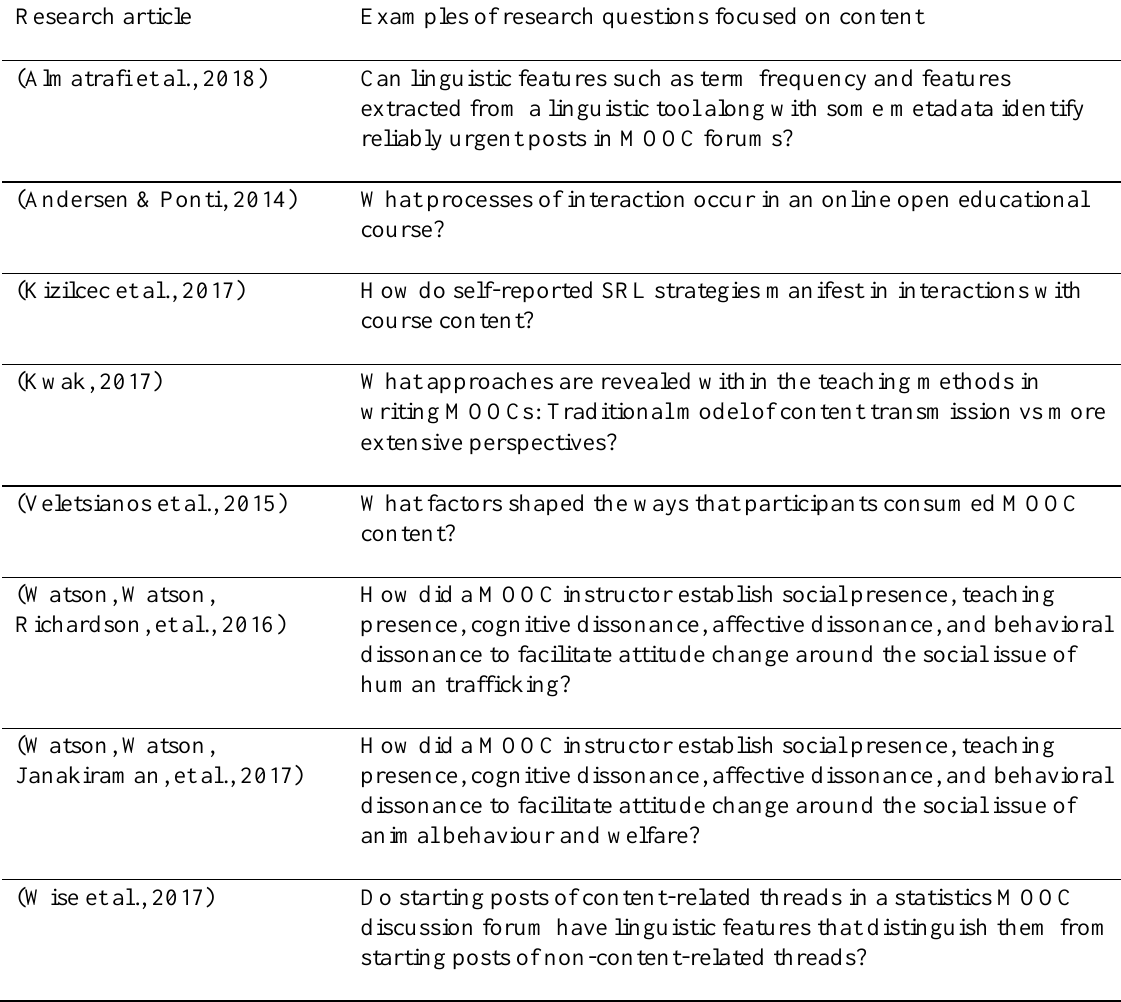
Table 6 Research Articles That Considered Content as an Object of